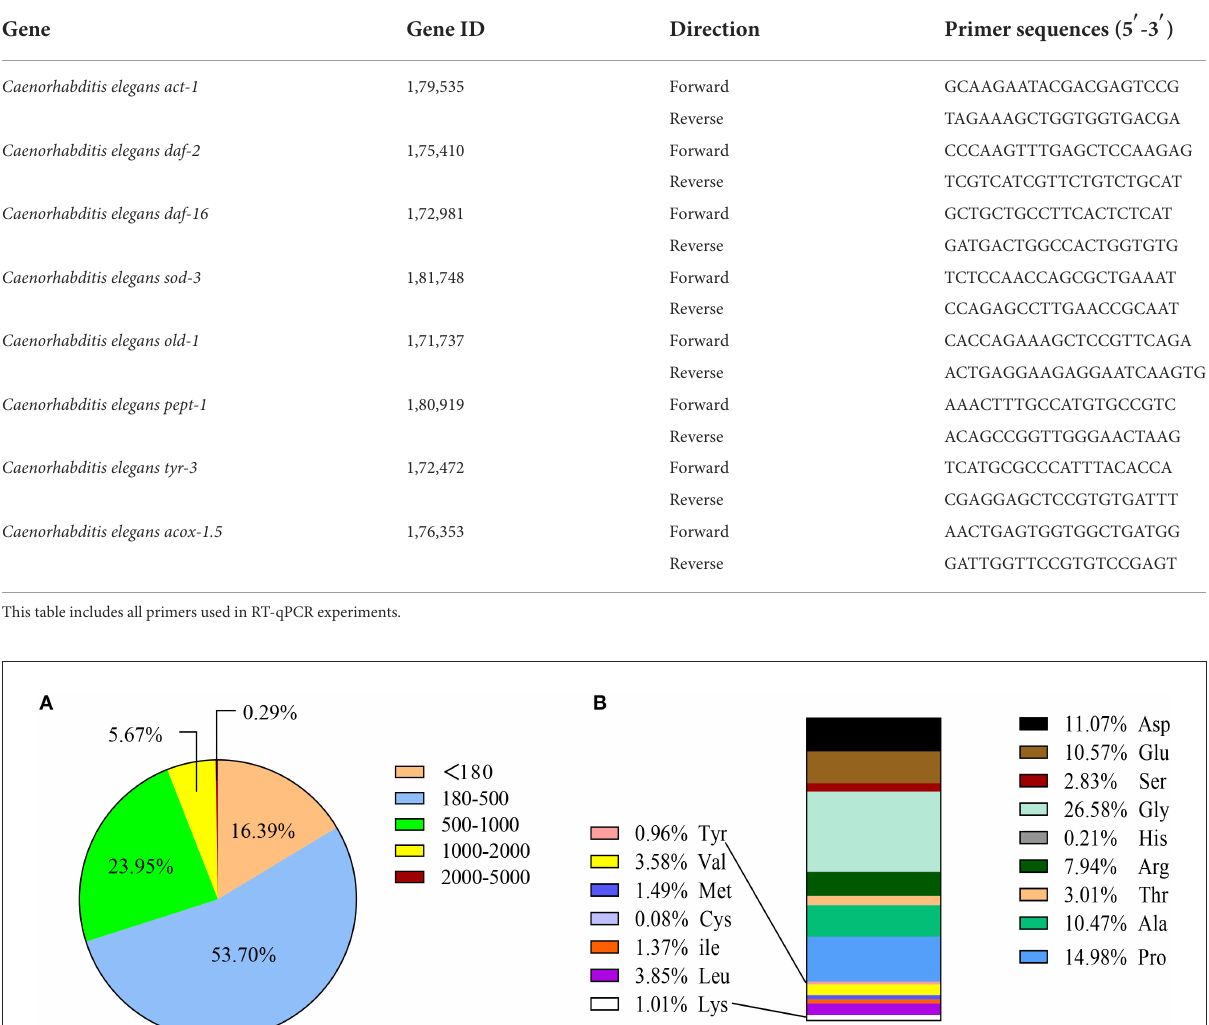
TABLE 1 Primer sequences.